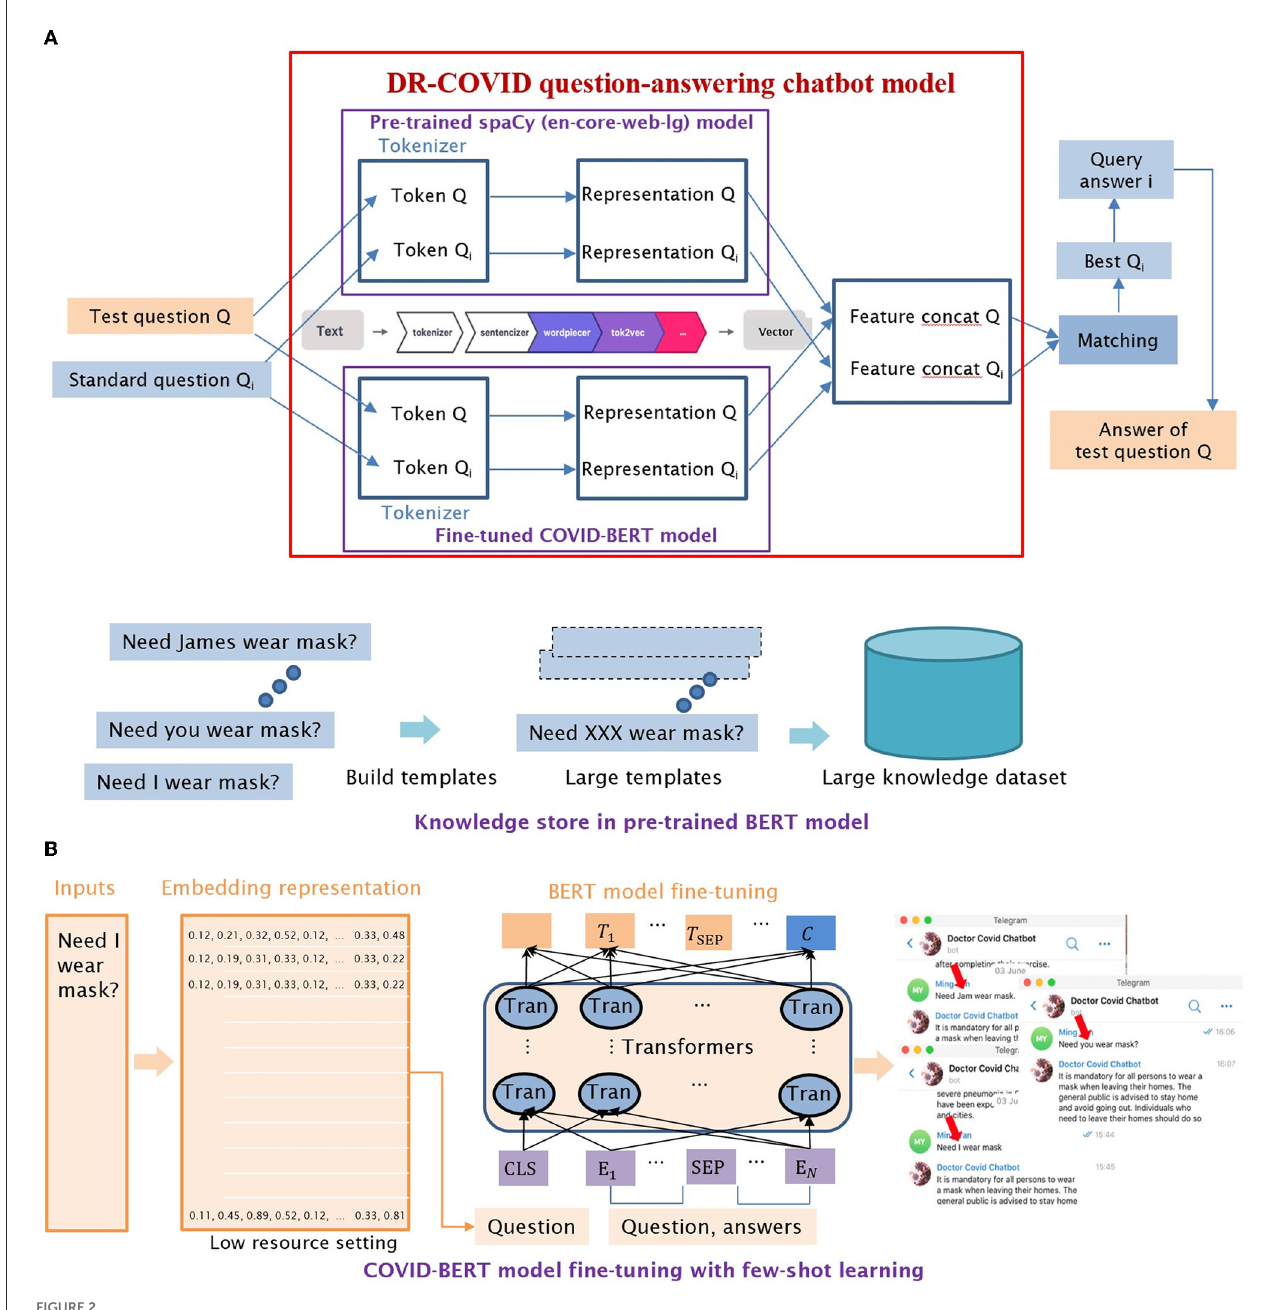
FIGURE2 Detailed illustrations of DR-COVID Natural Language Processing (NLP) chatbot architecture. (A) Illustration of NLP ensemble model architecture, which combined the vectors of two models with different weights, with the new vector used for similarity calculation. (B) Illustration of few-shot learning, which enabled the customized BERT model to be better trained when a limited number of MQAs was available in the training